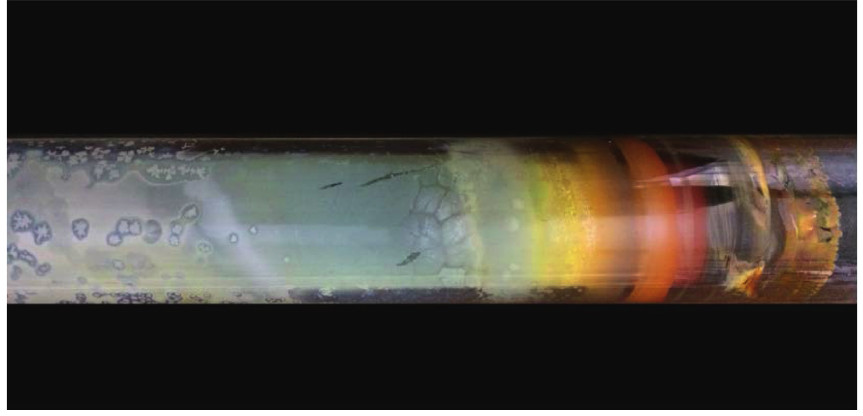
Figure 8: Photo of the volatile condensates at 1,200 °